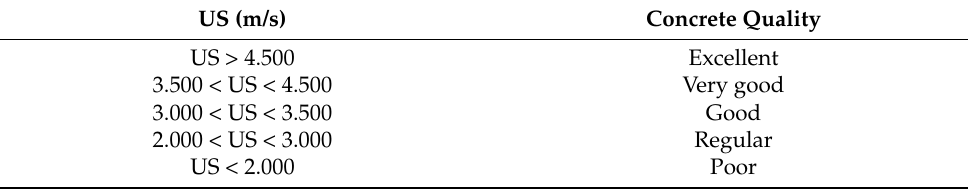
Table 3. Criteria for evaluating concrete based on ultrasonic speed at 28 days [65 – 67].